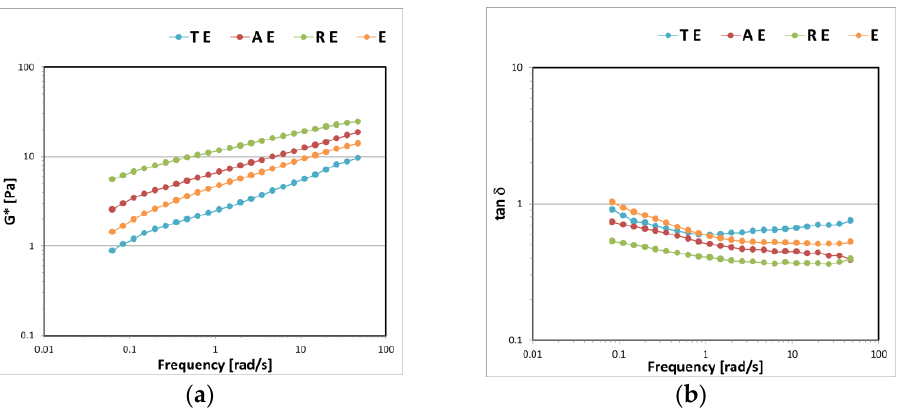
Figure 6. The trend of the rheological curves in the function of the oscillation frequency measured for the gel – creams E prepared with E at 0.7%, T E prepared with T at 0.2% w / w and E at 0.5% w / w , A E prepared with A at 0.2% w / w and E at 0.5% w / w , R E prepared with R at 0.2% w / w and E at 0.5% w / w : ( a ) complex modulus G* and ( b ) damping factor tanδ.